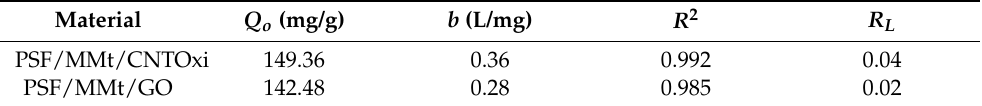
Table 6. Parameters of Langmuir isotherm constants of PSF/MMt/CNTOxi and PSF/MMt/GO surfaces respectively against the adsorption of Hg +2 , at pH 2.0 and 25 ◦ C (N = 3). Material Q o (mg/g) b (L/mg) R 2 R L PSF/MMt/CNTOxi 149.36 0.36